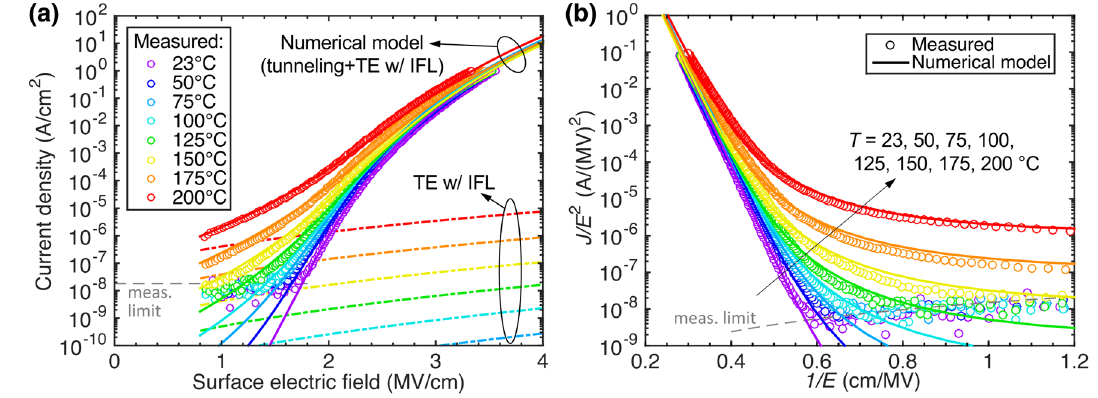
Fig. 10 a Temperature-dependent reverse leakage current density, with the numerical reverse leakage model. The contribution from thermionic emission (TE) with image force lowering (IFL) is also